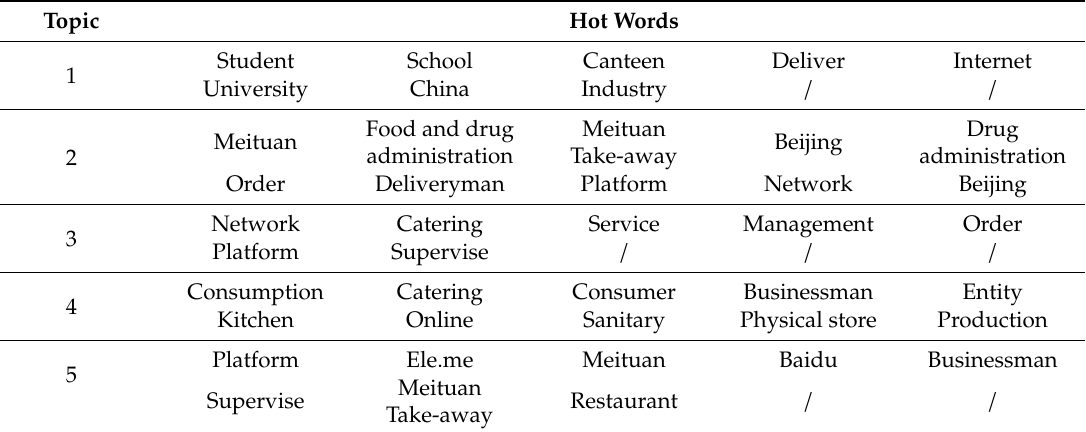
Table 5. Distribution of topics of positive emotion.